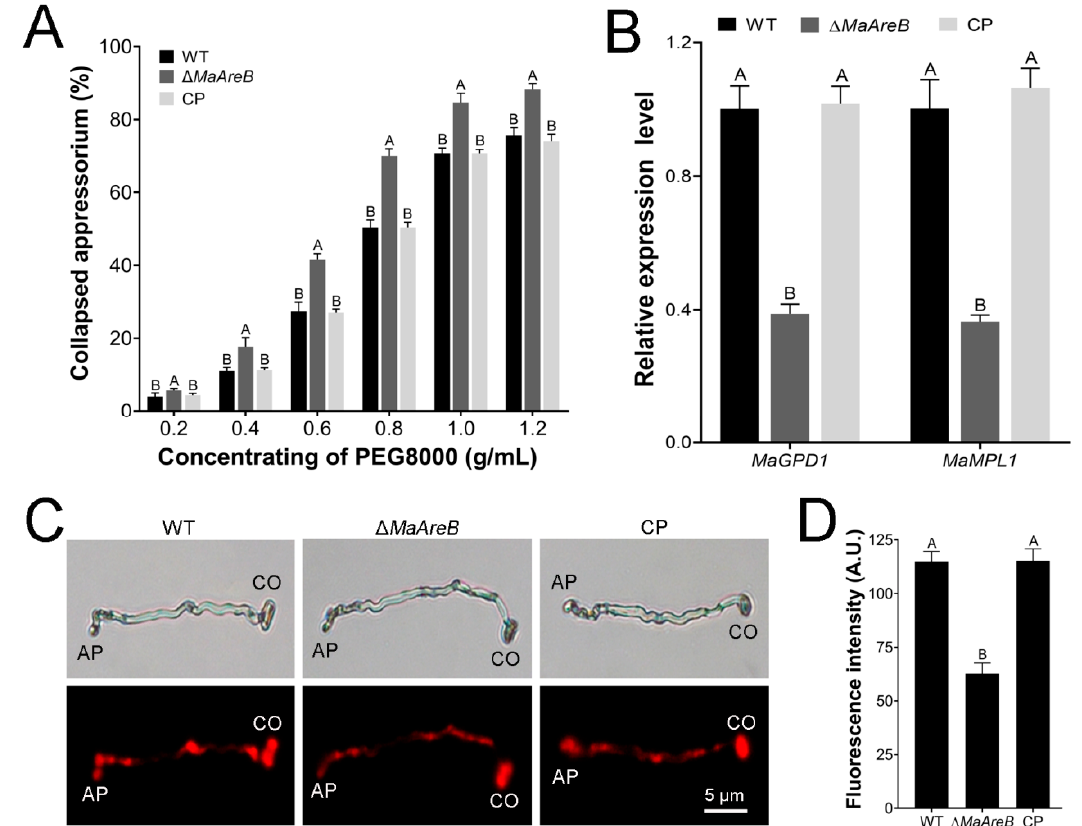
Figure 8. Lack of MaAreB decreased appressorial turgor pressure. ( A ) The appressorium collapsed rates of the WT, Δ MaAreB and CP strains after treatment with different concentrations of PEG8000. ( B ) qRT-PCR analysis of genes related to glycerol synthesis. ( C ) The neutral lipids stained using Nile red in appressoria. CO, conidium. AP, appressorium. Fungal samples were cultured on locust hind wings at 28 °C for 27 h. ( D ) Fluorescence intensity of the neutral lipids in appressoria. A.U., Arbitrary Units. A & B, p < 0.05 (Tukey’s HSD). The p -values in Figure 8A, B and D are listed in supplementary Table S3.